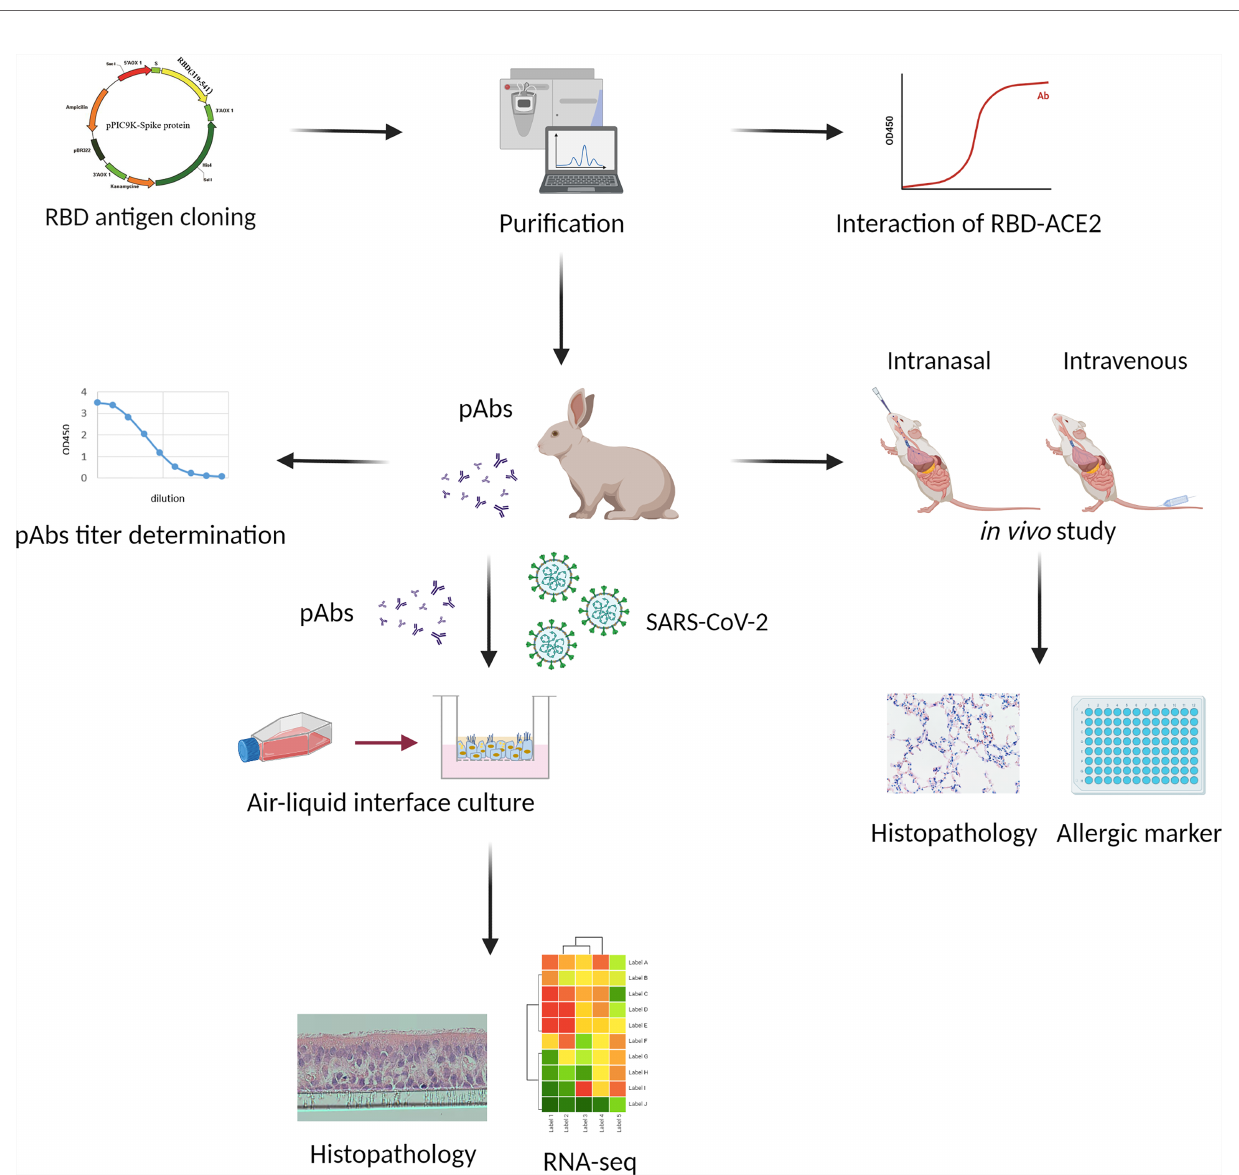
FIGURE 1 | Flowchart of study design. The receptor-binding domain (RBD) antigen was cloned into a vector and puri fi ed chromatographically. The anti-RBD polyclonal antibodies (pAbs) extracted from rabbit serum were tested in vitro and in vivo . The binding ef fi cacy of antibodies was tested in terms of EC 50 . The viral- infected human bronchial epithelial cells (HBECs) cultured in air – liquid interphase (ALI) were used to test the safety and ef fi cacy of the anti-RBD pAbs based on the results of viral quanti fi cation, histopathology, and RNA sequencing (RNA-seq) analyses. Finally, the anti-RBD pAbs were tested in vivo , and samples were collected for histopathology and allergic marker